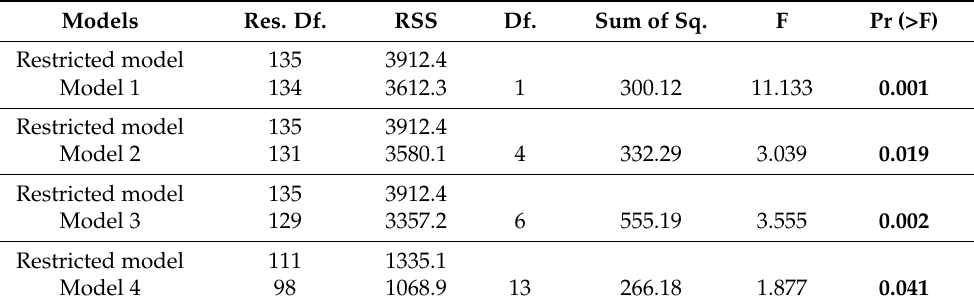
Table 5. Model fitting comparison test using a multiple linear regression approach. Models Res.